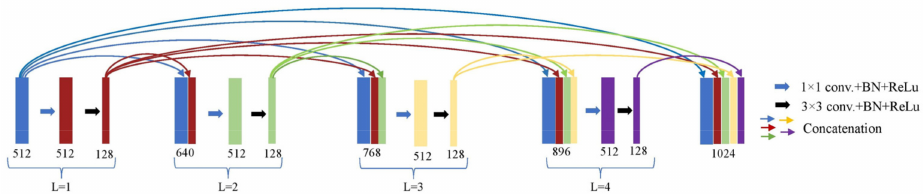
Figure 4. Last dense block with four layers of encoding part, where k 5 = 128 and f 5 =